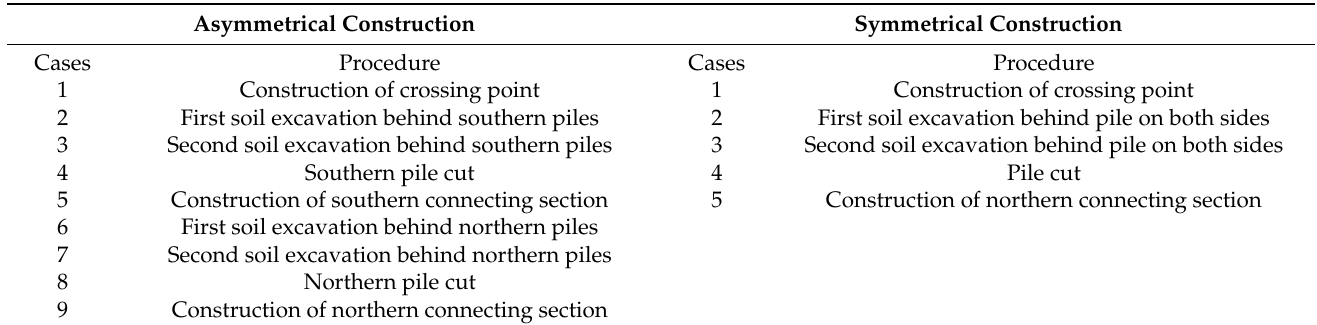
Table 3. Procedure of asymmetrical and symmetrical